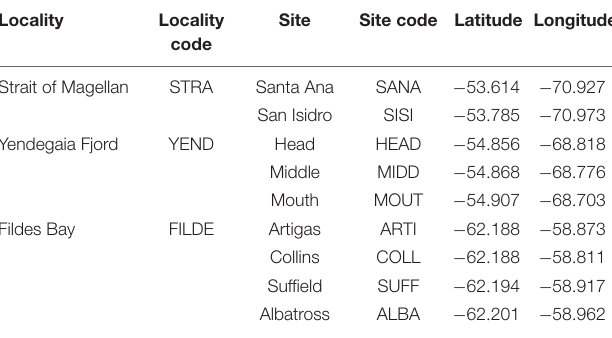
TABLE 1 | Names and codes of regions and sites analysed in this